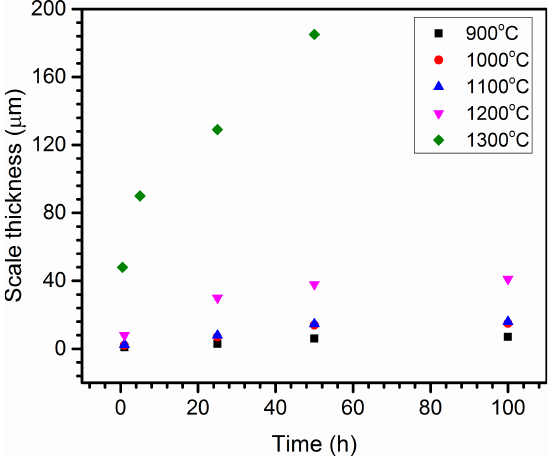
Figure 5: Variation of the thickness of the oxide scale with time at different